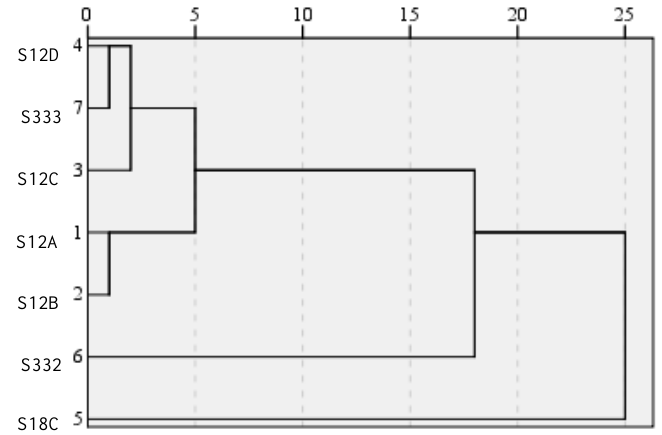
Figure 5. Dendrogram showing the clustering of sampling sites according to the water quality parameters of selected sites.